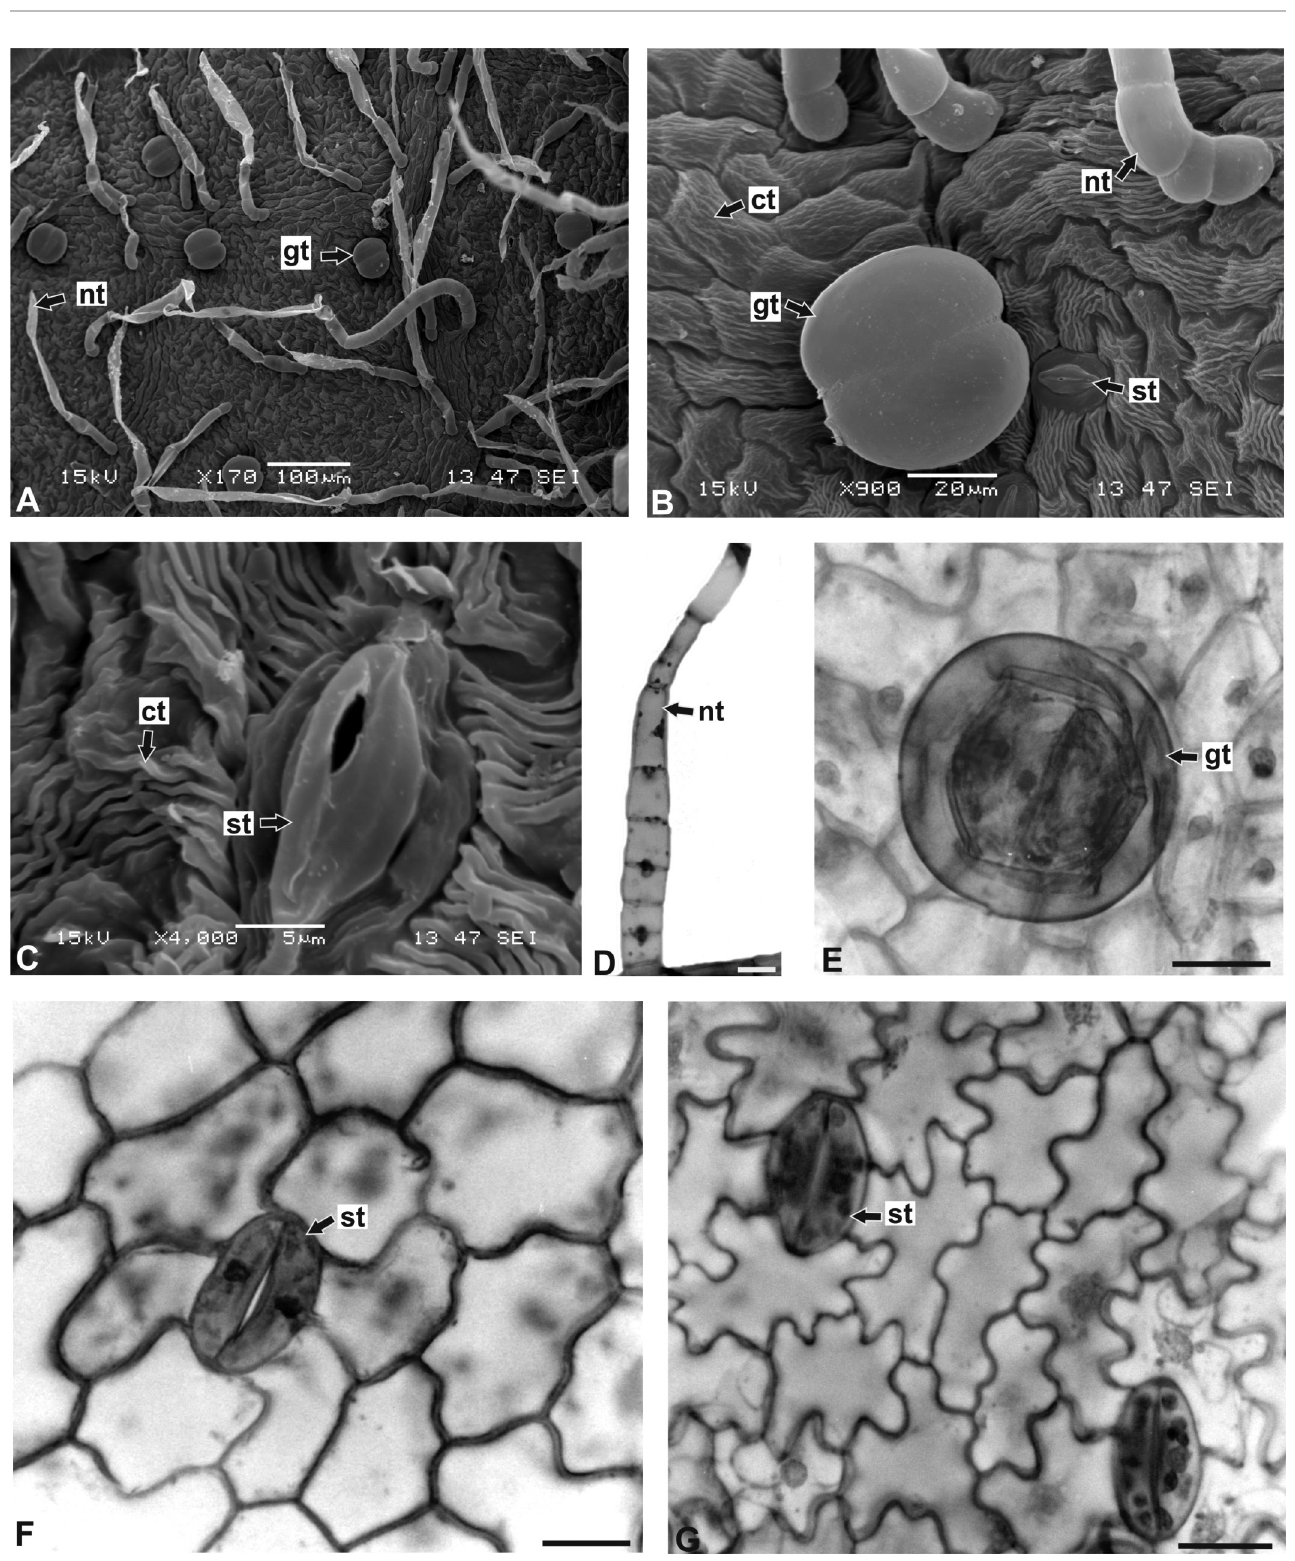
FIGURE 1 - A-G: Gymnanthemum amygdalinum (Delile) Sch.Bip. ex Walp. – leaf: A-C. Detail of non-glandular and glandular trichomes, stomata and striate cuticle under SEM; D. Medium and basal portion of a non-glandular trichome; E. Capitate glandular trichome; F, G. Adaxial and abaxial epidermal surfaces, respectively. Abbreviations: ct – cuticle, gt – glandular trichome, nt – non- glandular trichome, SEM – scanning electron microscopy, st – stomatum. Bar = 20 µm